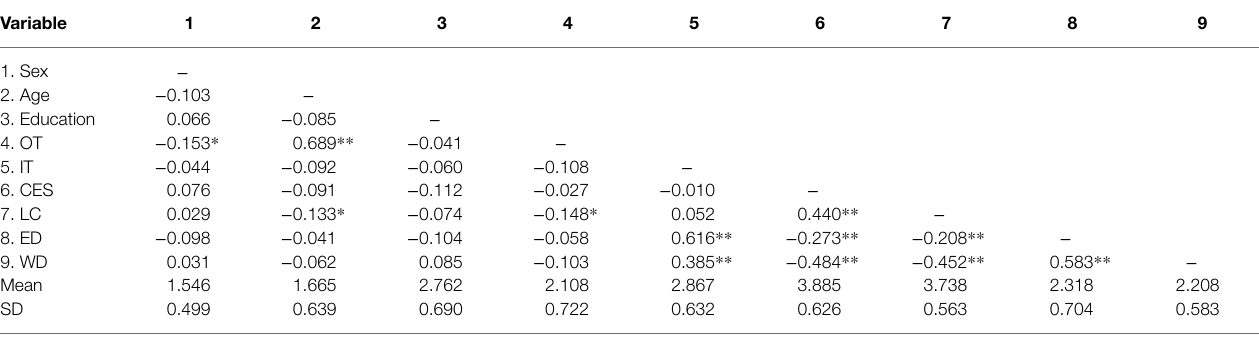
TABLE 2 | Descriptive statistics and correlations of variables. Variable